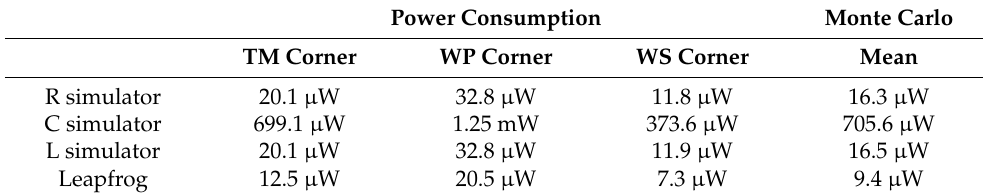
Figure 12. Monte Carlo analysis for each OTA transconductance. Table 6. Corner analysis of the power